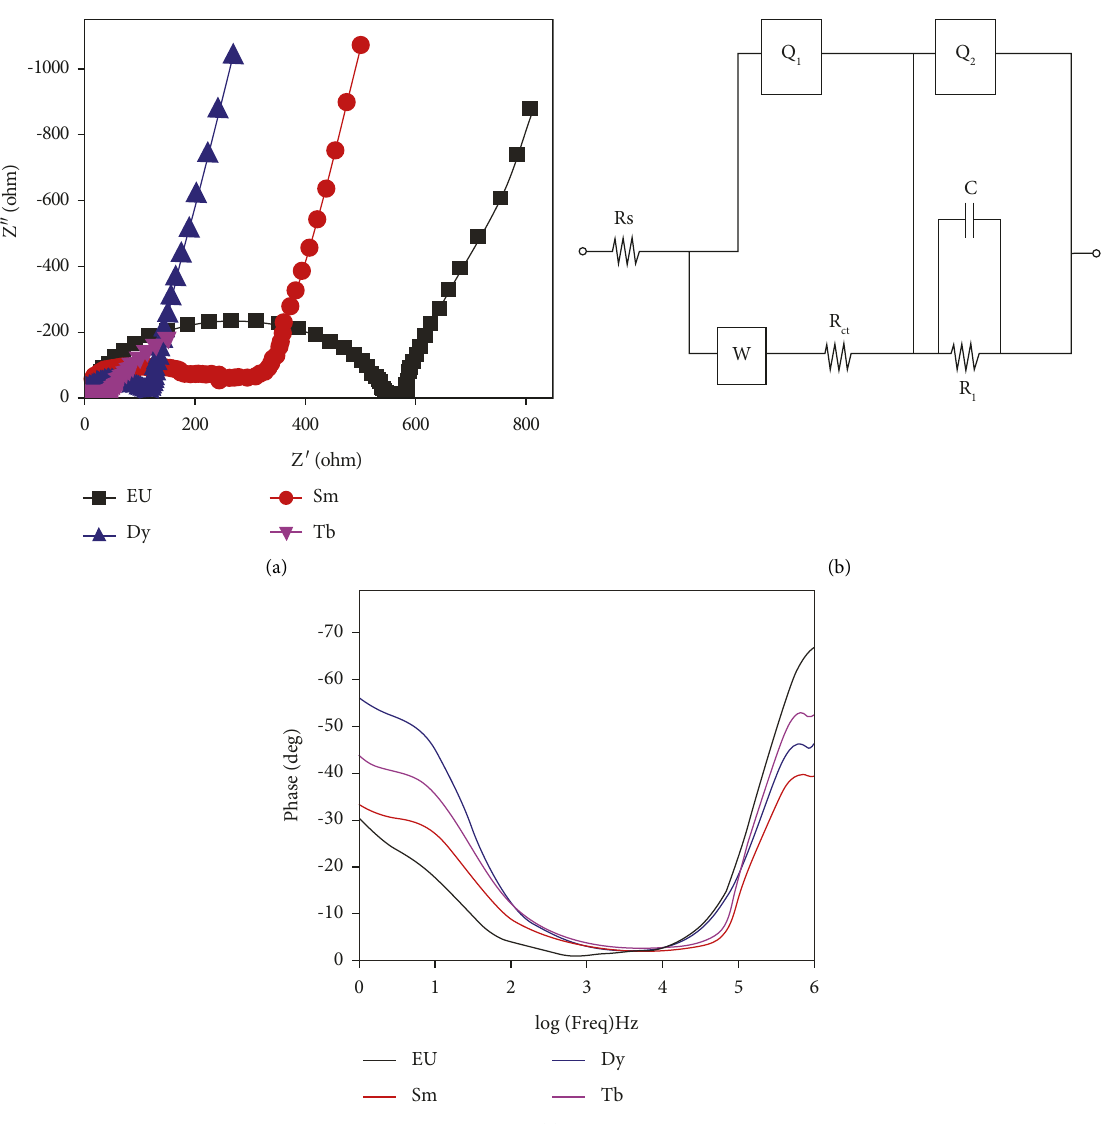
3+ (5mol %) nanophosphor. 10 Si 6 O 27 :RE